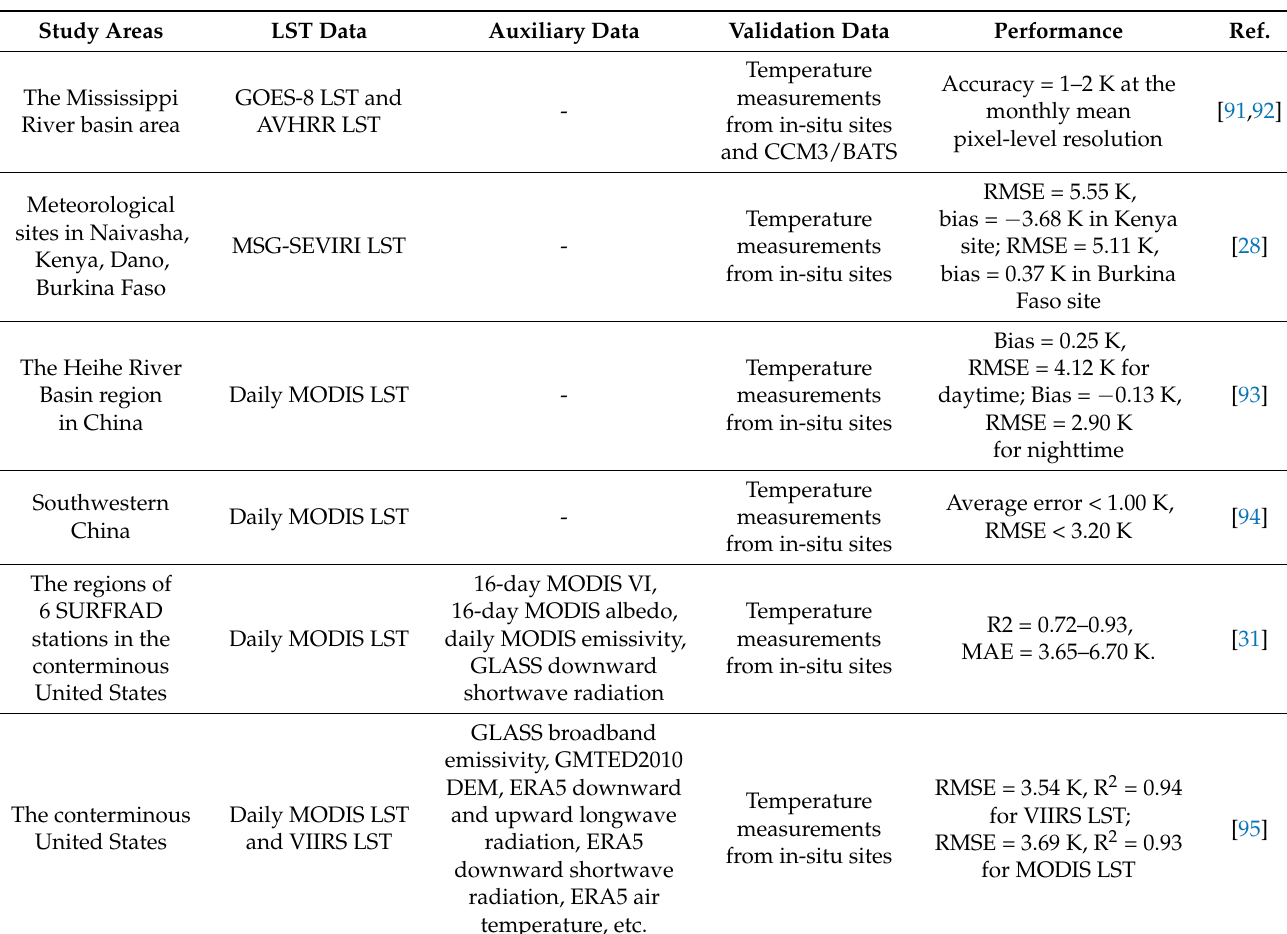
Table 8. Summary of SEB-based gap-filling